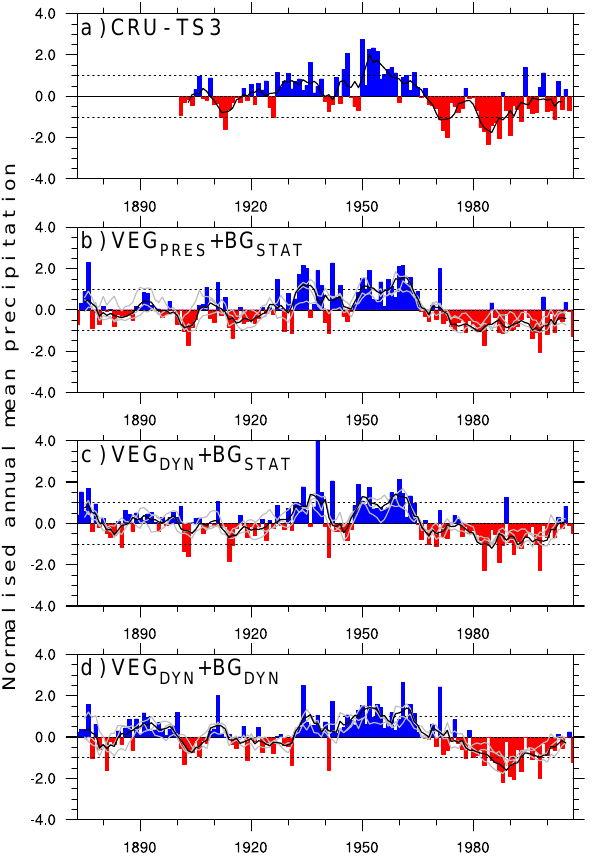
Fig. 3. (a) Mean annual precipitation over the years 1901–2006, and (b) difference between the annual mean precipitation of the wet years (1938–1967) and the mean of the dry years (1969–1998). Crosses: observed precipitation or ensemble mean precipitation. Open circles: individual ensemble members.